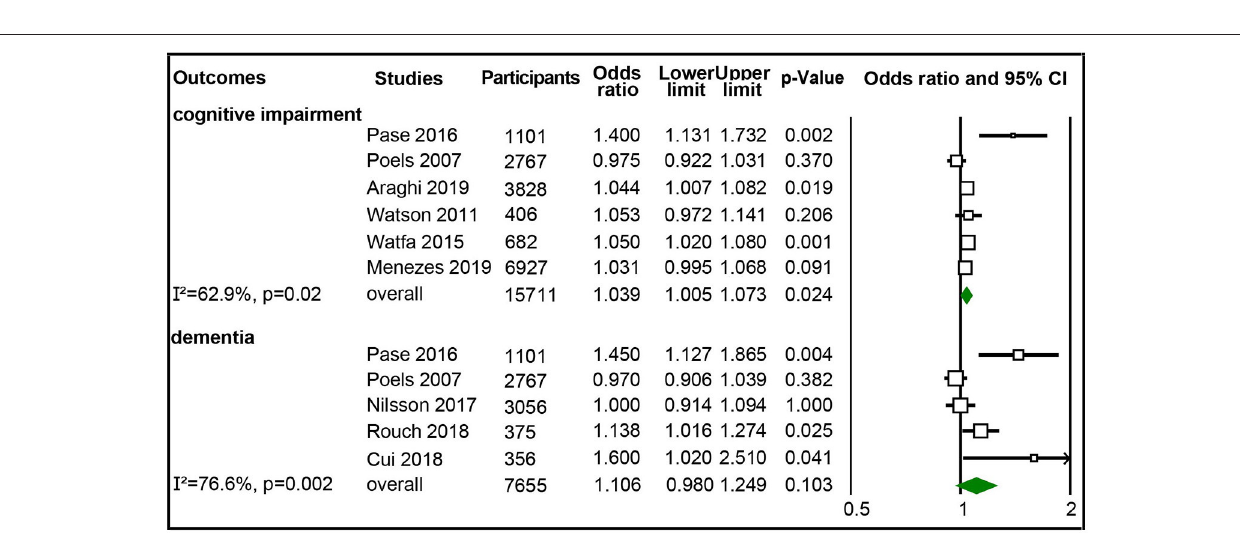
FIGURE 4 | Forest plot of association between continuous aortic pulse wave velocity (PWV) (m/s) and cognitive impairment and